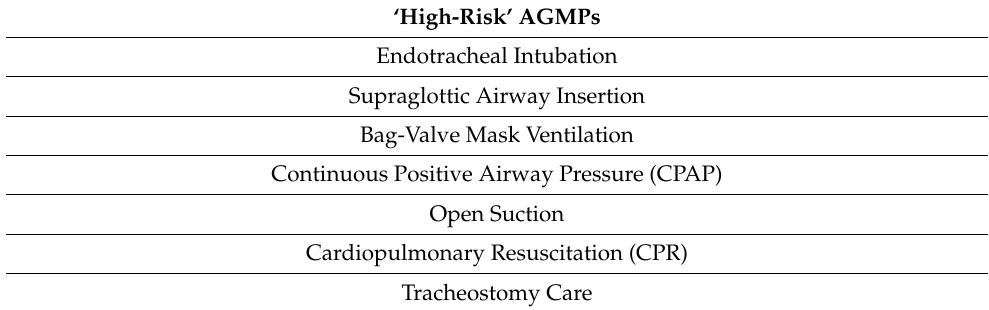
Table 2. Aerosol-Generating Medical Procedures defined for the purposes of our program as ‘high-risk’.